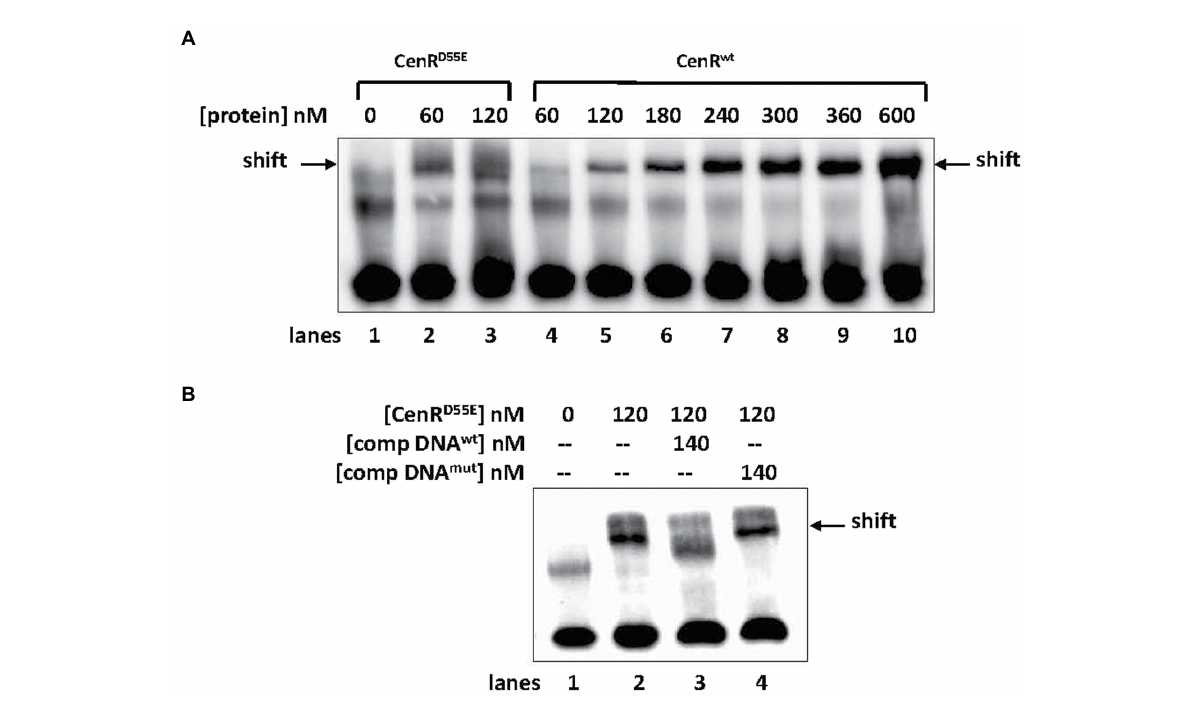
FIGURE 9 Binding of CenR protein to 60 bp srlA promoter region (see “Materials and methods”; Supplementary Figure S4). (A) Biotinylated probe (20 fmol) associated with no protein (lane 1) and increasing concentrations of purified (see Supplementary Figure S3) CenR D55E (lanes 2–3) or CenR wt (lanes 4–10) protein. (B) Probe binding challenged with unlabeled wt (lane 3) or unlabeled mutated DNA (lane